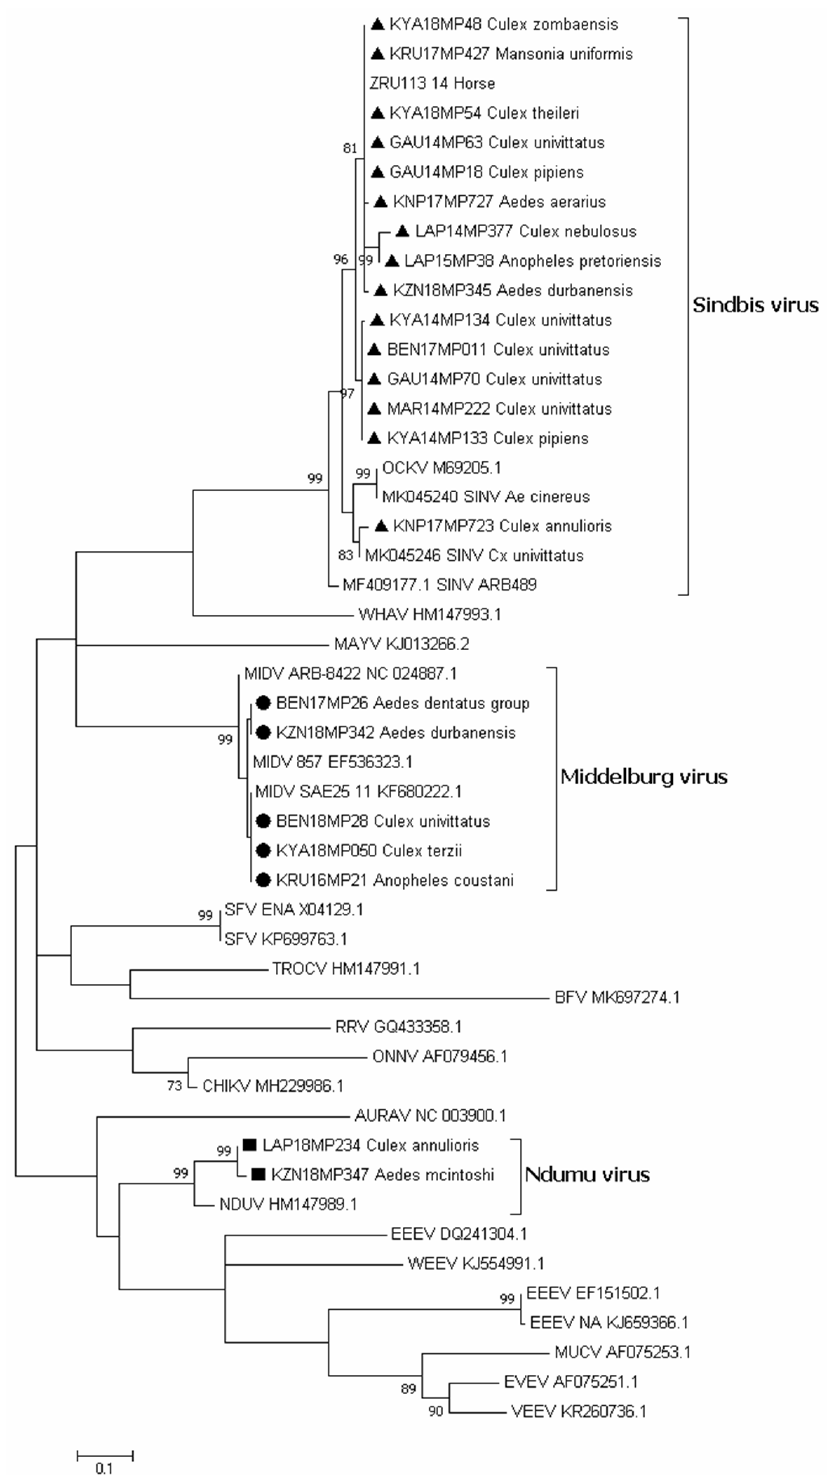
Figure 3. Phylogenetic comparison of the gene nsP4 alphavirus-positive sequences identified in this study. The phylogenetic tree of the positive sequences is based on the 48 sequences of the 180 bp of the nsP4 gene used for alphavirus genus PCR identification. The tree was constructed by employing the program MEGA 7 and the maximum likelihood method based on the Kimura 2-parameter model with 1000 bootstrap replicates. GenBank accession numbers are indicated. Numbers on internal branches indicate bootstrap values. The samples that are a part of this study are marked with a triangle (SINV), a dot (MIDV), and a square (NDUV).